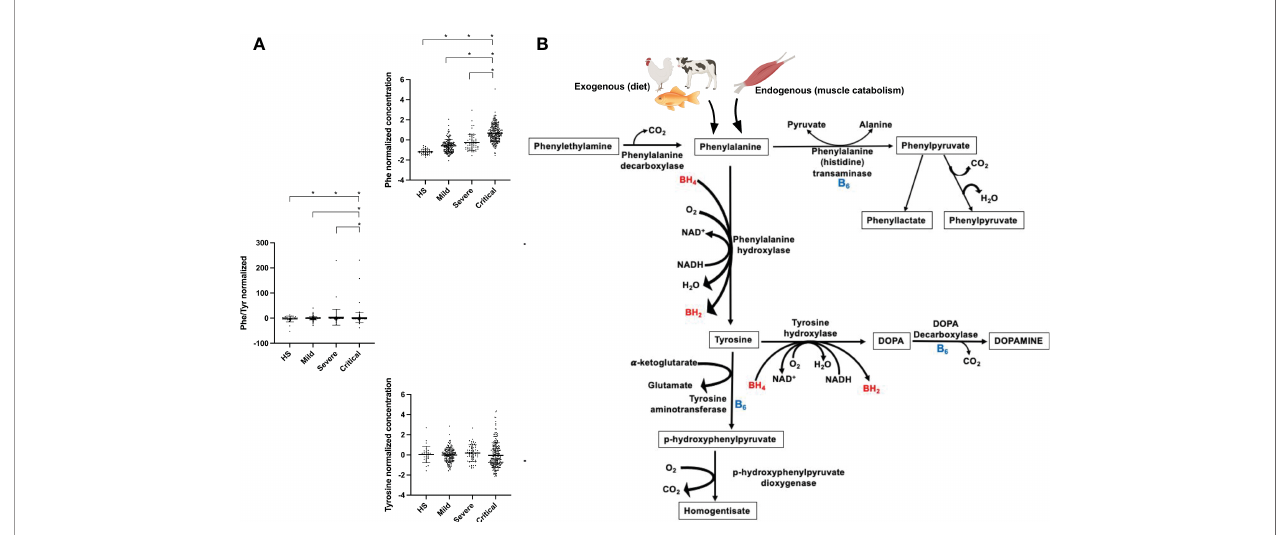
FIGURE 5 | Phenylalanine (A) and tyrosine (B) metabolic pathways and observed metabolic changes in COVID-19 patients. AS, Aspartate synthetase; ASL, Argininosuccinate lyase; ARG, Arginase; NO, Nitric oxide; BH4, Tetrahydrobiopterin; BH2, Dihydrobiopterin; HS, Healthy subjects; SA, succinylacetone; TCA, tricarboxylic acid